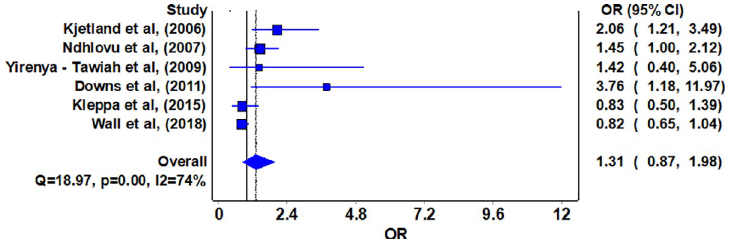
Fig 2. Forest plot of impact of Urogenital schistosome infection to HIV infection in women.